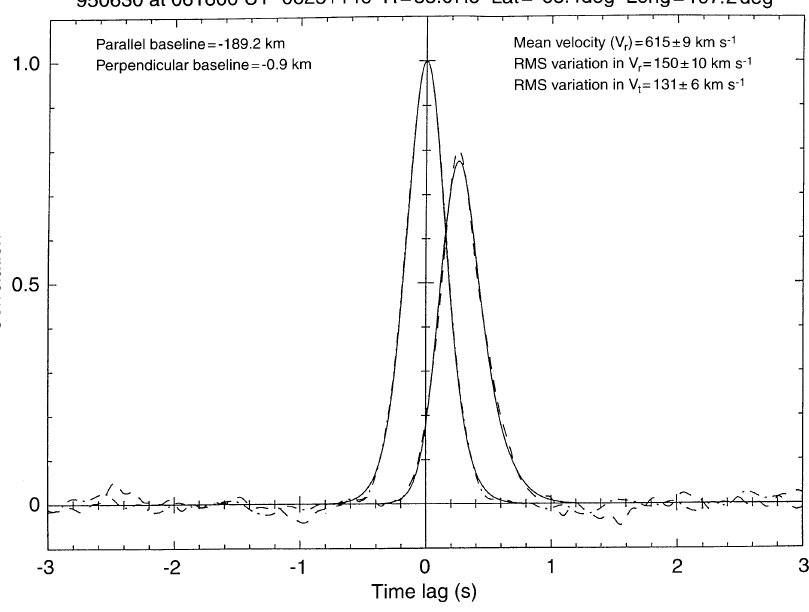
Fig. 2. Observations of 0625 # 146 on 30 June 1995, showing a clear fast stream at high latitude (single stream analysis). The dashed line represents the data and the solid line the model fit